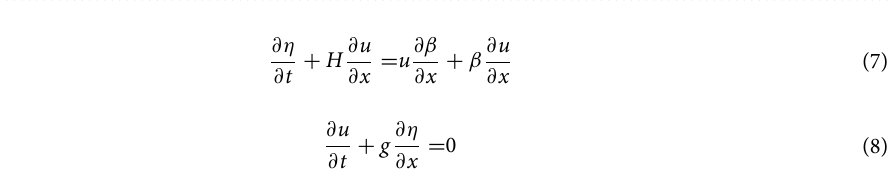
ω ) used to model the temperature fluctuations over KOBE and PERU earthquake −